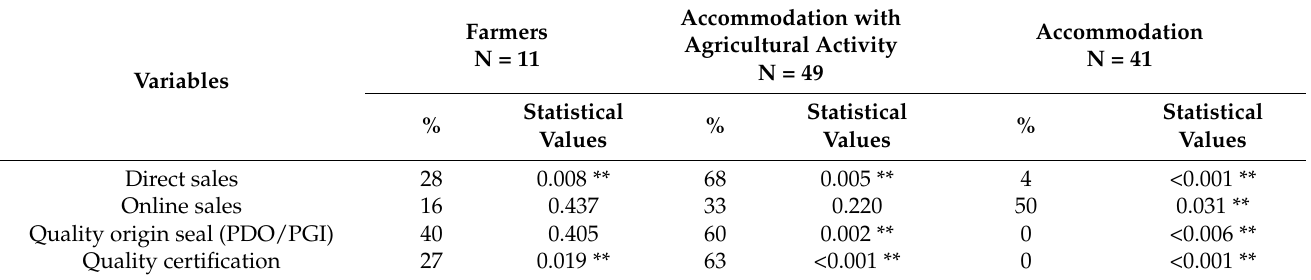
Table 6. A comparison of economic variables between accommodation and other entrepreneurial agritourism models (Chi-square analysis of dummy